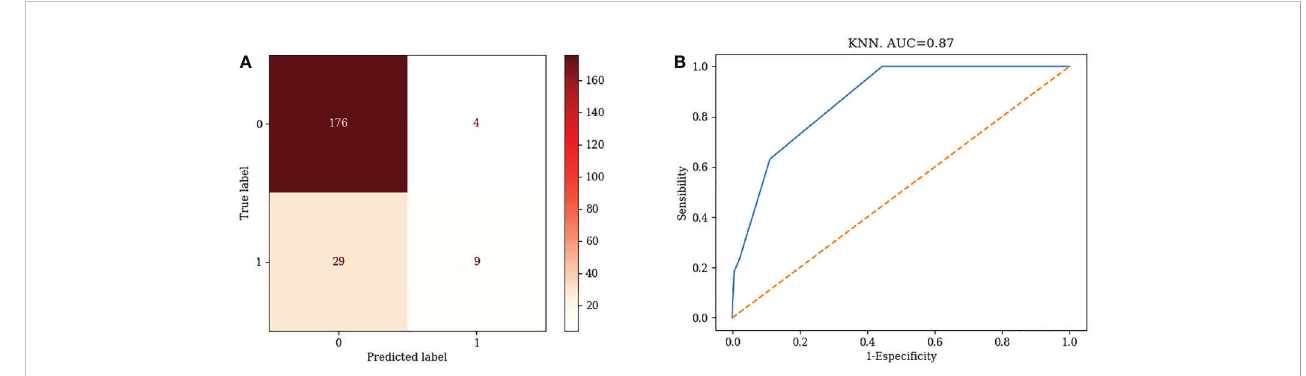
FIGURE 1 Confusion matrix and ROC curve of KNN